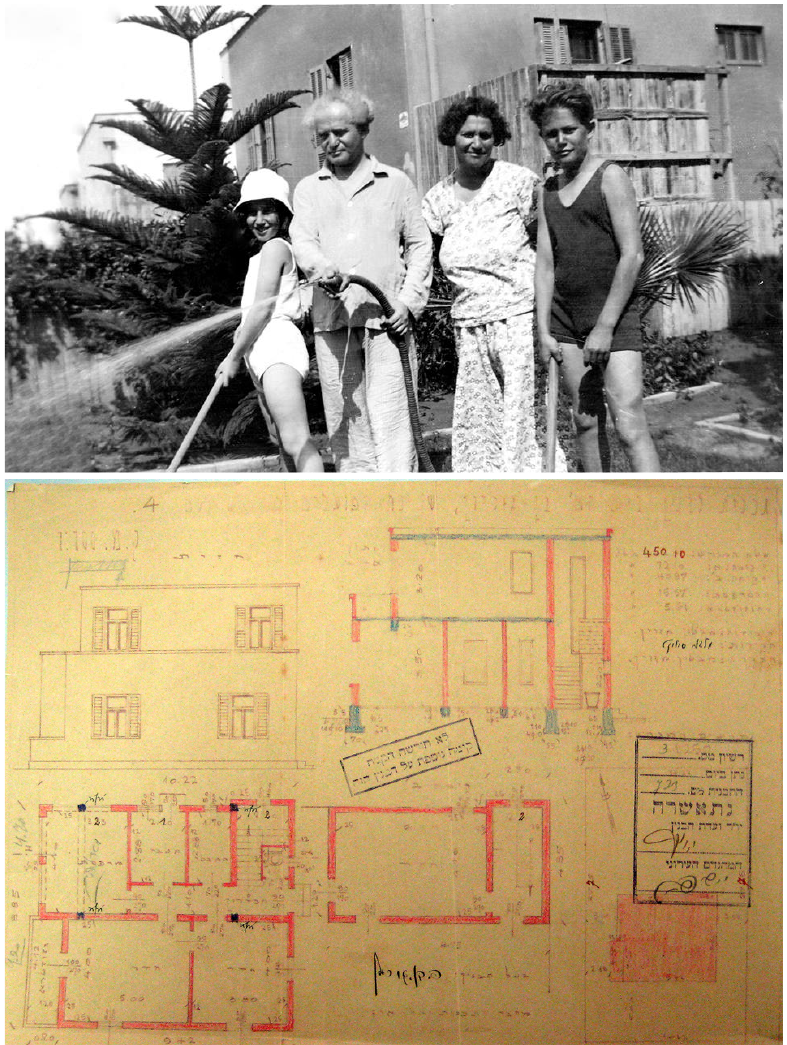
Figure 9. Workers’ Neighborhood A. Top: Ben Gurion family in front of their house, Worker Neighborhood A, 1935 (Aner, 1988). Bottom: Building permit for the house of David Ben-Gurion, Municipal Worker Neighborhood plot number 4 (“Building permit for the house of David Ben-Gurion”,